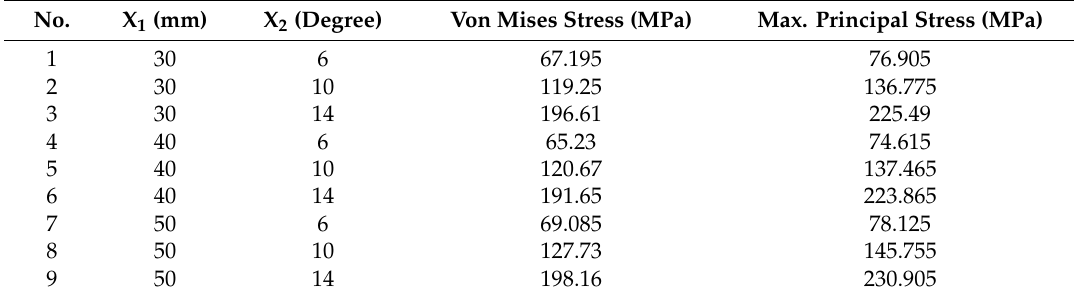
Table 2. The values of the stresses resulted from the finite element method (FEM) analyses.